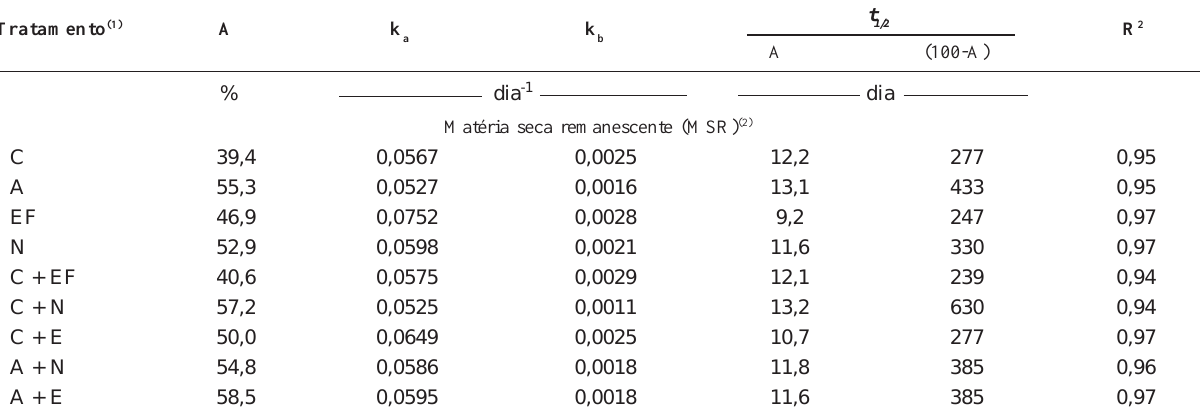
(1) C=centeio; A=aveia-preta; EF=ervilha forrageira; NF=nabo forrageiro; E=ervilhaca comum. (2) MSR = A e - k at + (100-A) e - k bt